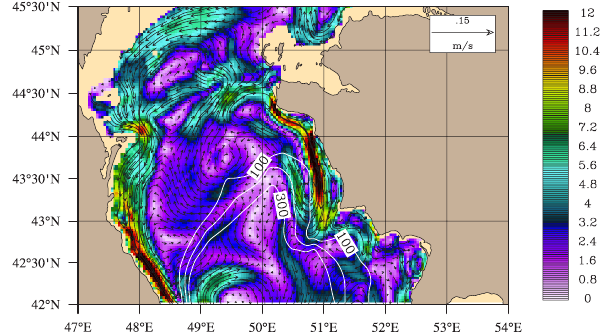
Figure 5. Model-derived current over the MCS in in July. The southward flow along the northeastern coast of the MCS is evident in this